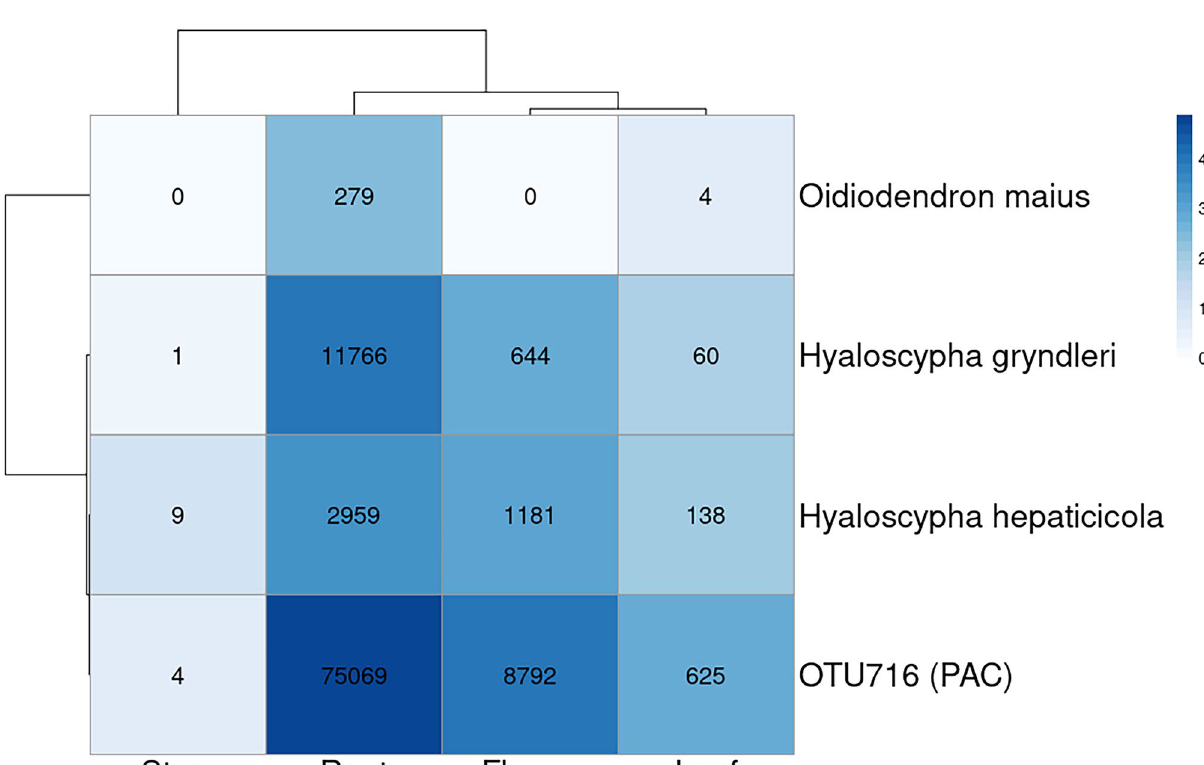
Figure 5. Distribution of reads from the mycorrhizal species O. maius , H. gryndleri and H. hepaticicola , and the core OTU716 assigned to the DSE P. fortinii (PAC) in the V. myrtillus organs (double clustering based on average linkage algorithm and Pearson correlation). Numbers in the matrix represent the absolute reads supporting the OTUs. The color key represents the log scale of the number of